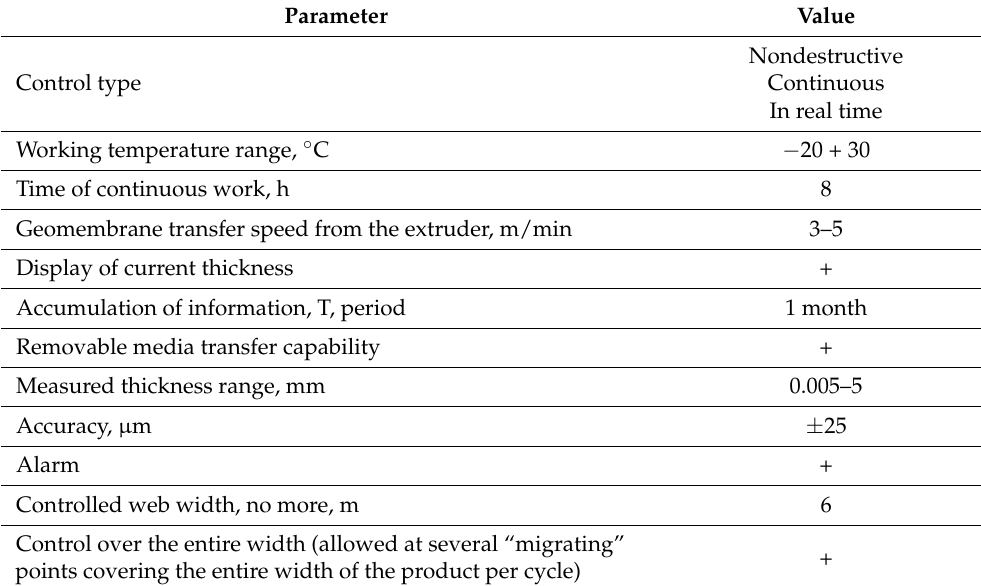
Table 2. Parameters for choosing a measurement method.